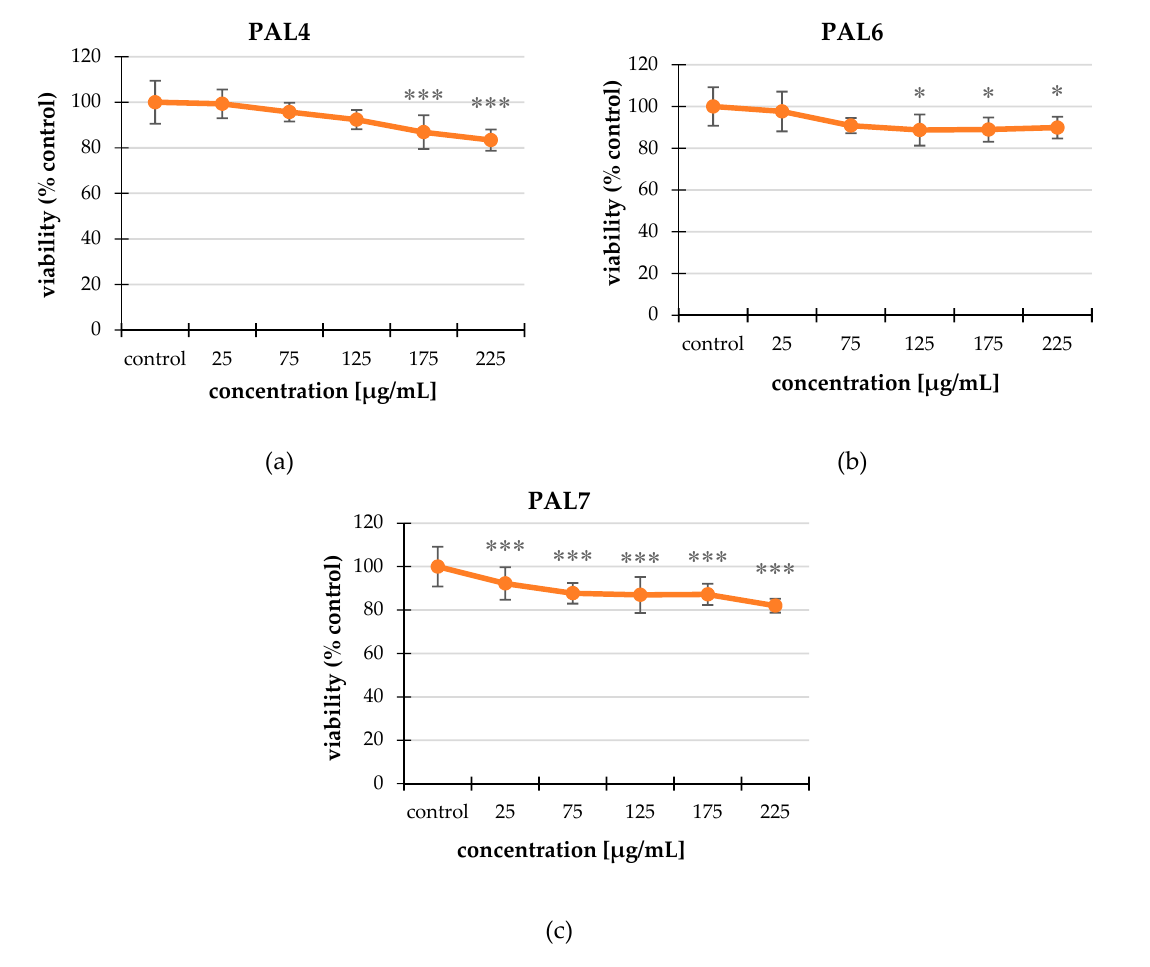
Figure 1. The effect of the extracts on the cell viability of the HT-29 line studied using a neutral red (NR) uptake assay. The most effective extracts were PAL4 ( a ), PAL6 ( b ), and PAL7 ( c ). The values are compared to the control, regarded as 100%; * p < 0.01, ** p < 0.005, *** p < 0.001, one-way ANOVA, Dunnett’s test.